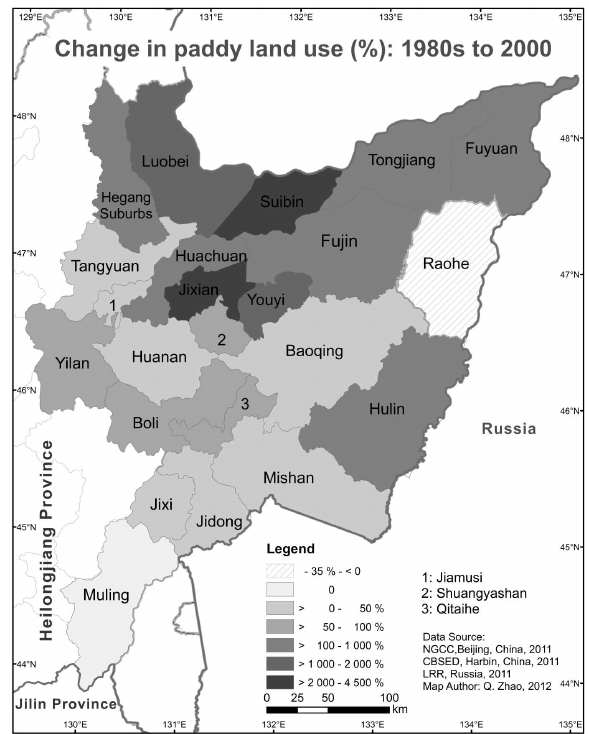
Figure 2. Change in paddy land use (%) from the 1980s to 2000